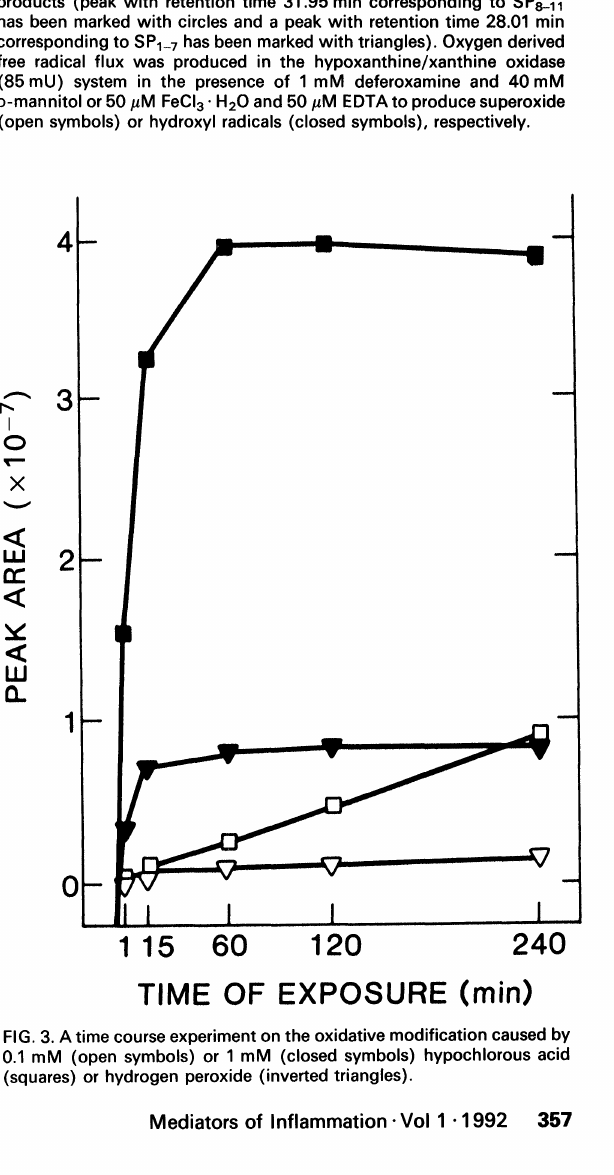
FIG. 3. A time course experiment on the oxidative modification caused by 0.1 mM (open symbols) or mM (closed symbols) hypochlorous acid (squares) or hydrogen peroxide (inverted